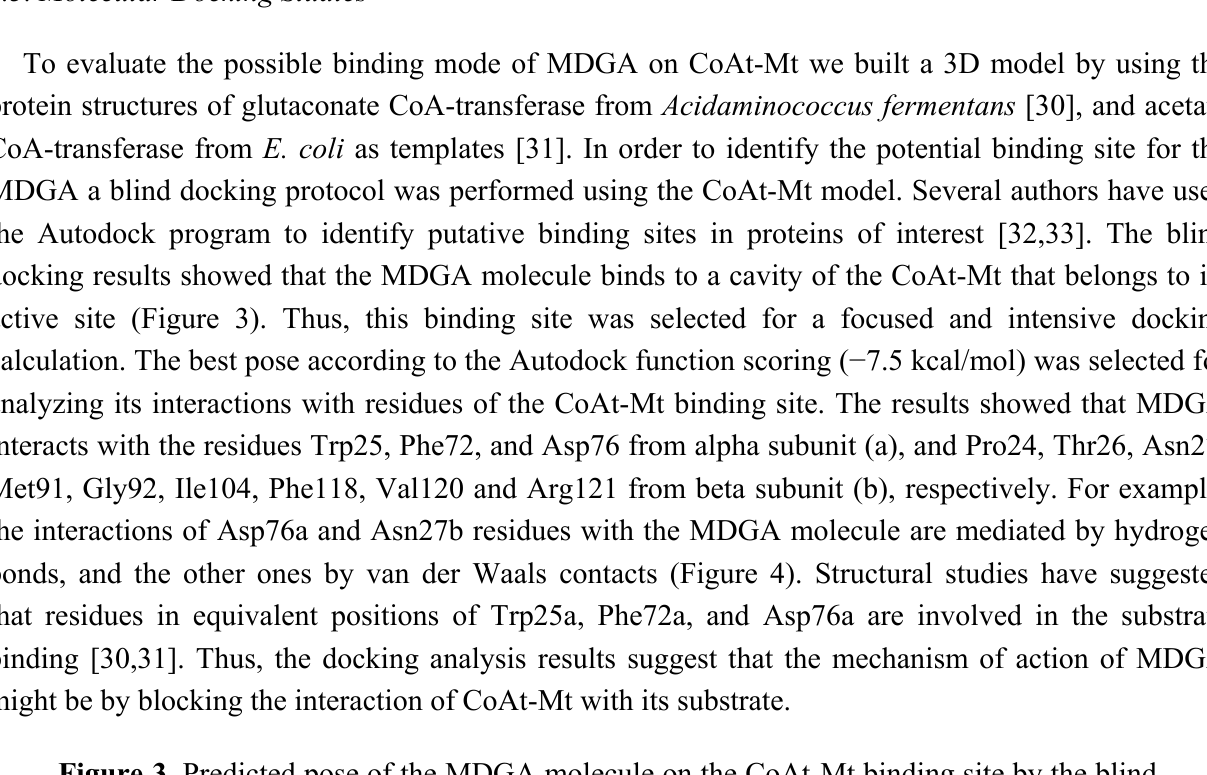
Figure 3. Predicted pose of the MDGA molecule on the CoAt-Mt binding site by the blind docking protocol. This figure was created with the Chimera program